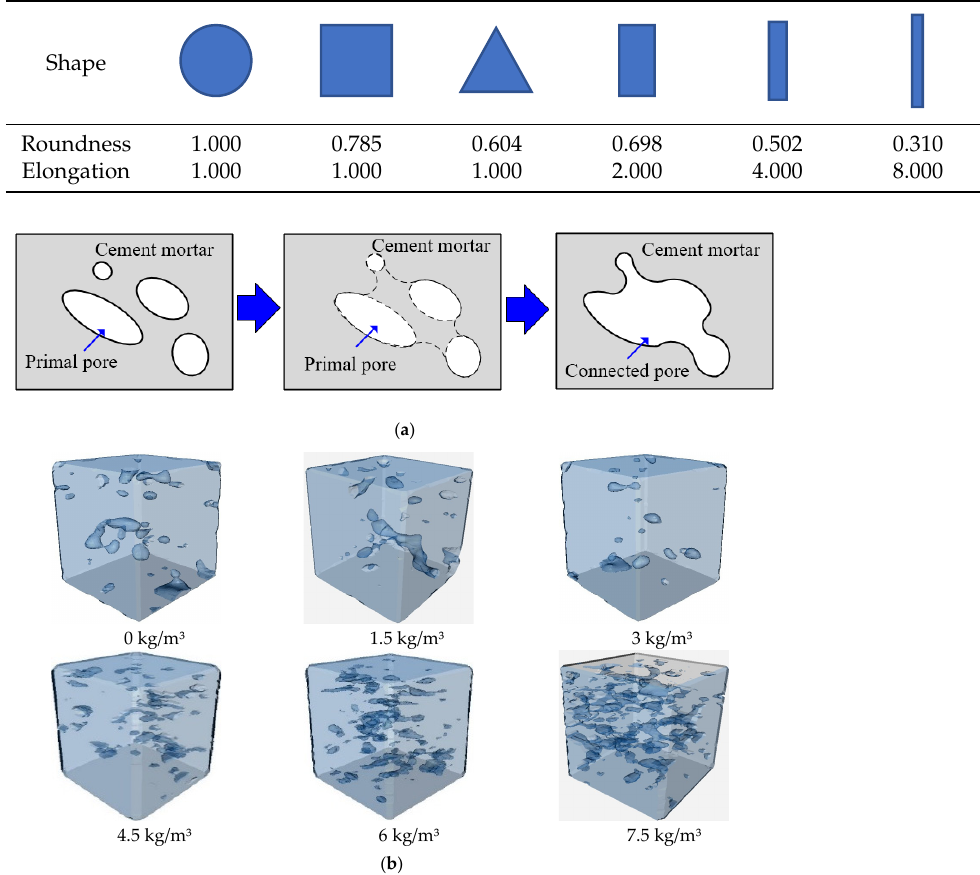
Table 7. Roundness and elongation corresponding to pore shape.